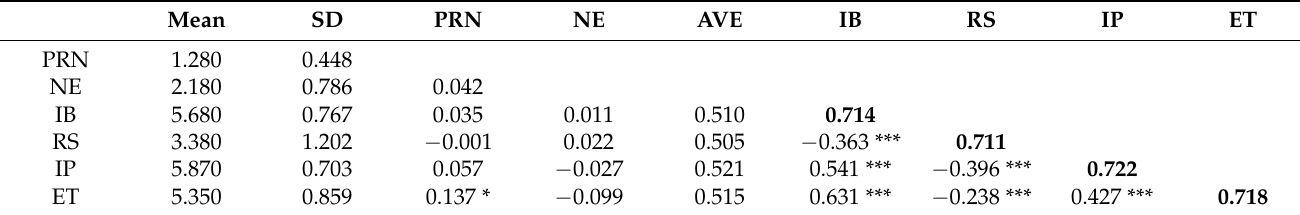
Table 3. Mean, SD, correlation coefficients, and the square root of average variance extracted values.